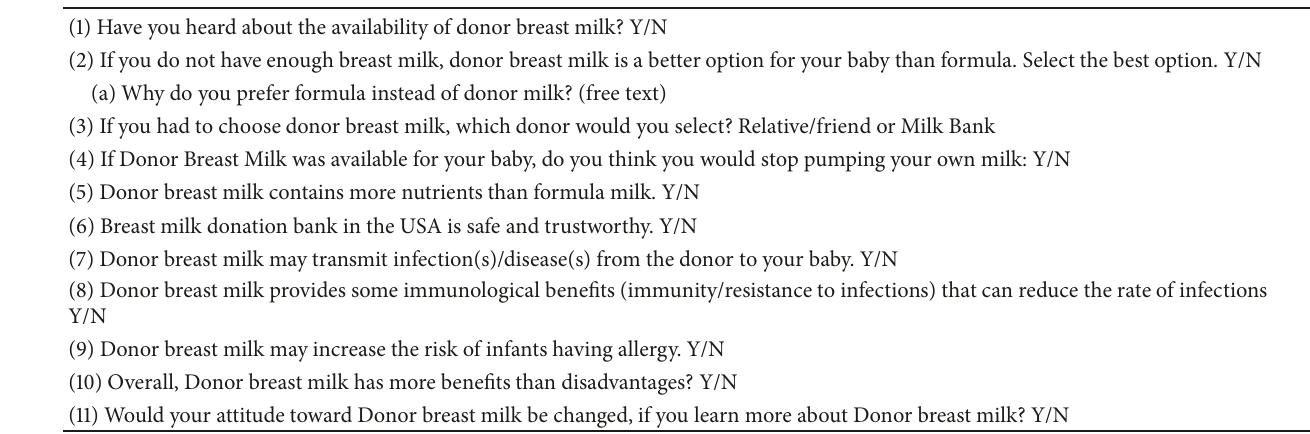
Table 1: Donor Breast Milk